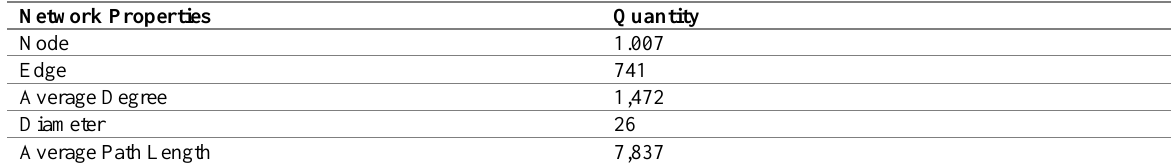
Table 1: Social Network Properties for RedDoorz